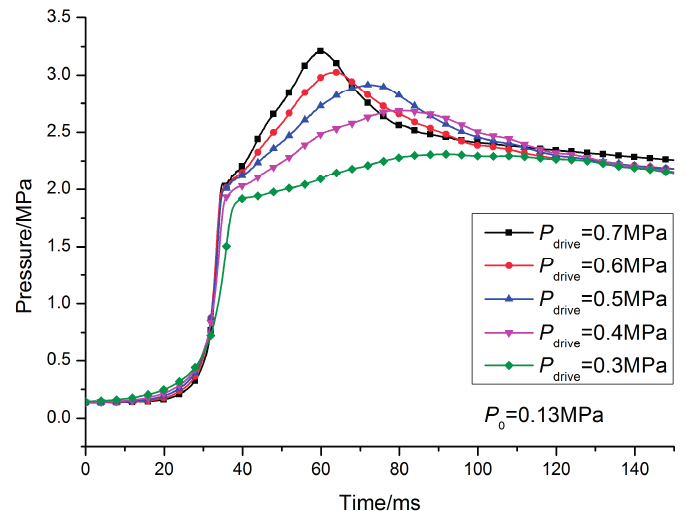
Figure 6. Effect of driving gas pressure on the compression pressure (before modification of the hydraulic buffer).